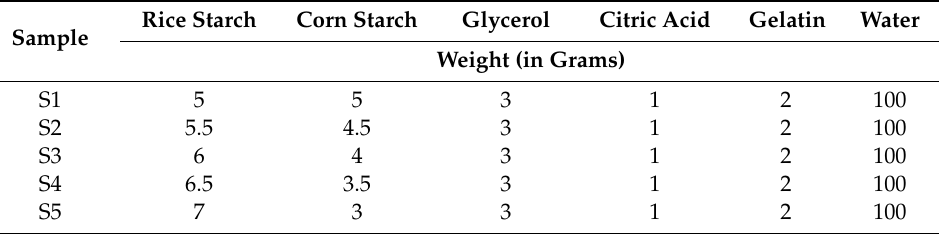
Table 3. Composition of prepared